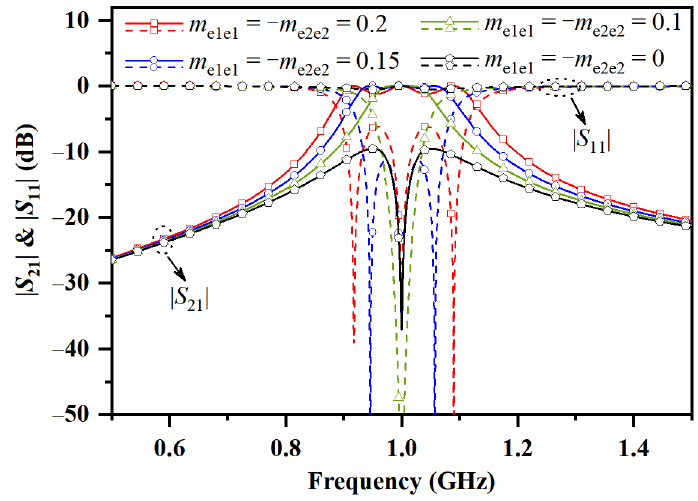
Figure 6. Theoretical curves for varying m e1e1 and m e2e2 with fixed m oo = 0 and Q e = 28.